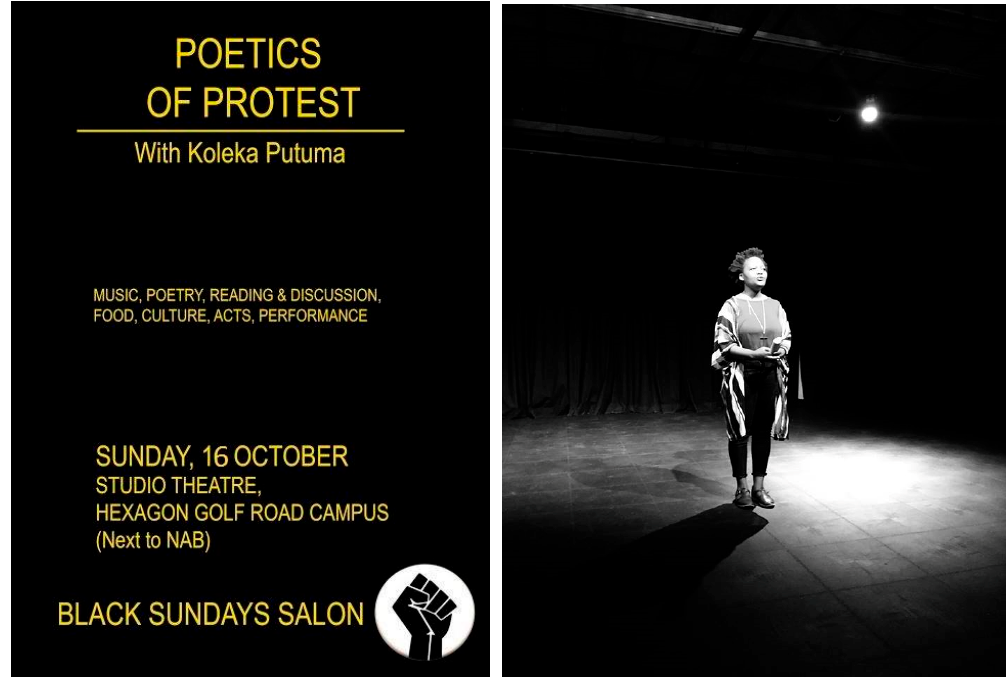
Figure 2. Poetics of Protest.